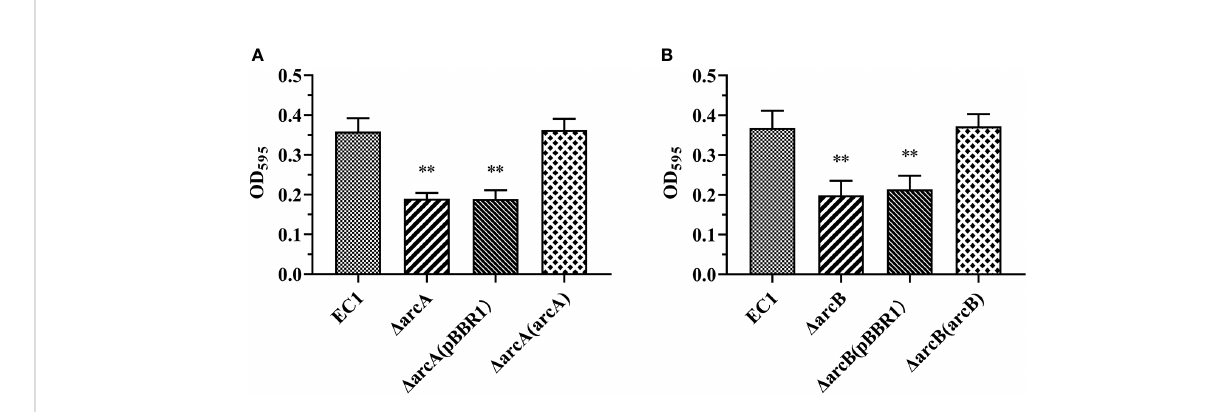
FIGURE 1 The deletion mutants of arcA and arcB shown decreased capacity for bio fi lm formation compared with D . oryzae wild-type strain EC1. (A) Quanti fi ed adhesion bio fi lm biomass of wild-type EC1, D arcA, D arcA(pBBR1) and complemented strain D arcA(arcA) using crystal violet staining. (B) Quanti fi ed adhesion bio fi lm biomass of wild-type EC1, D arcB, D arcB(pBBR1) and complemented strain D arcB(arcB) using crystal violet staining. The experiments were repeated three times in triplicates. ** p < 0.01, Student ’ s t